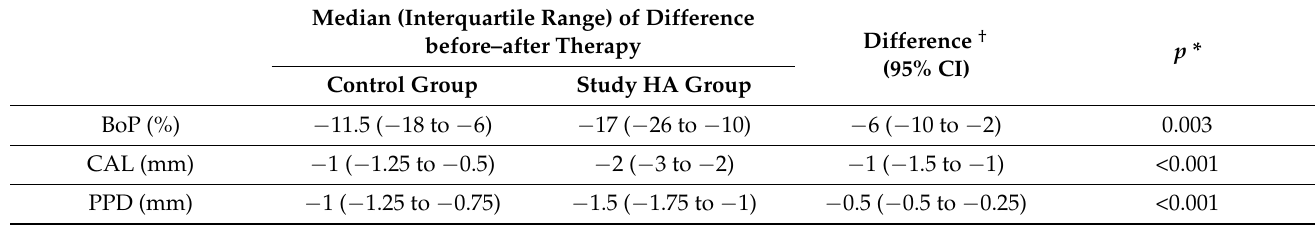
Table 3. Absolute differences before and after therapy between